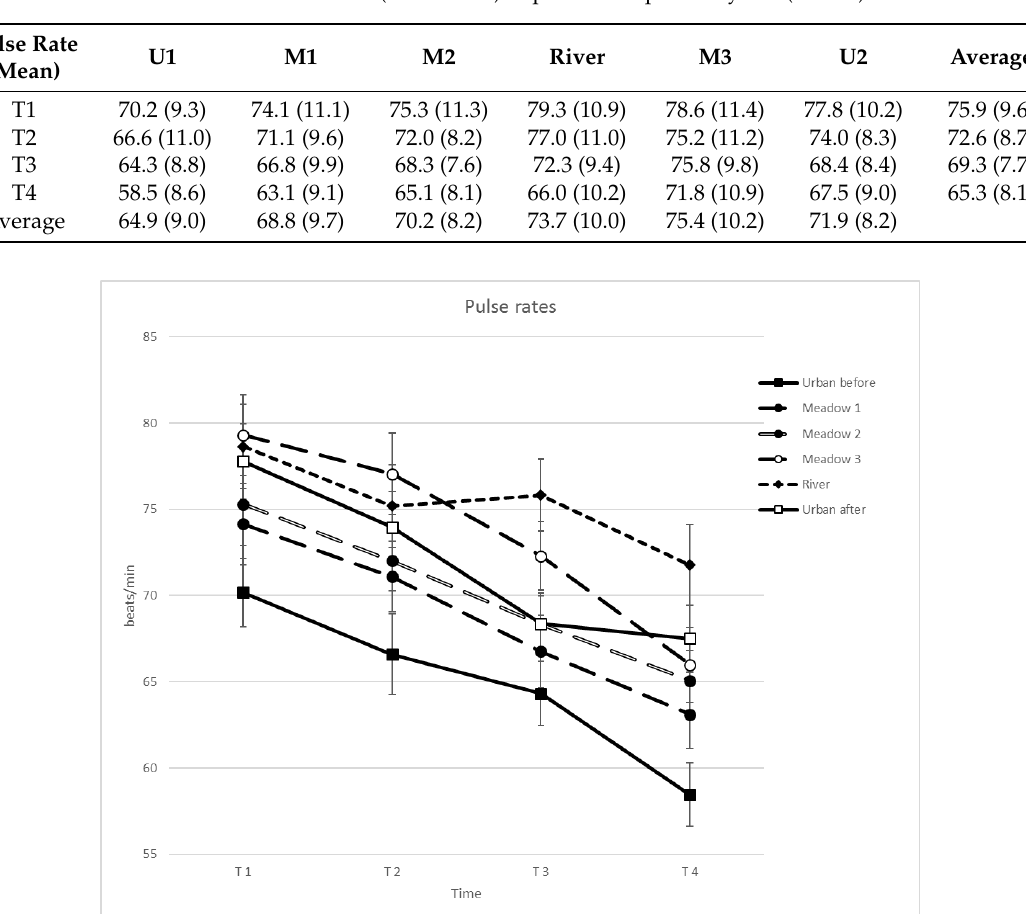
Figure 3. Mean pulse rate per site and time ( N = 22).